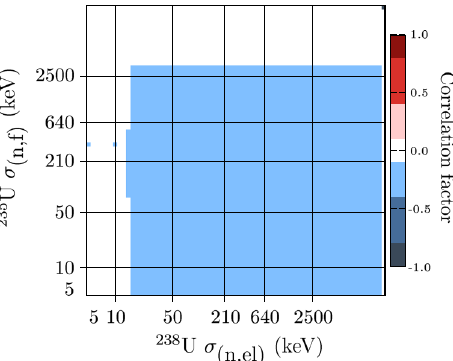
Fig. 8. Comparison between the posterior (weighted), prior (unweighted) and the IAEA standard 235 U(n,f) cross section and evaluated uncertainties (the lines denotes the cross sections whereas the bands are the uncertainties).